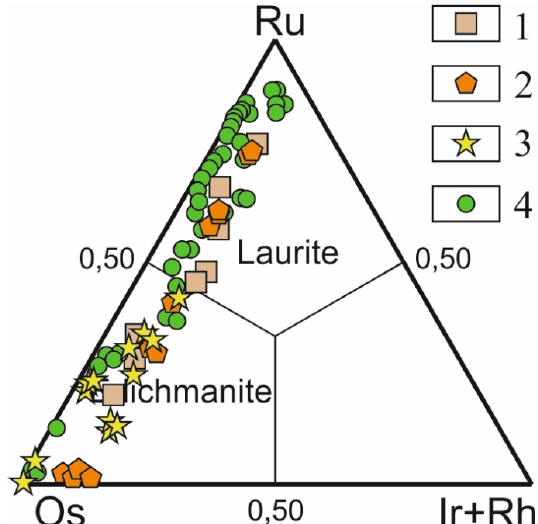
Figure 12. Compositional range (at. %) of laurite–erlichmanite from chromite-platinum ore zones of the Svetloborsky massif (1), the Vershinniy eluvial placer (2), the Travyanistyi proximal placer (3), and the Glubokinskoe distal placer (4).